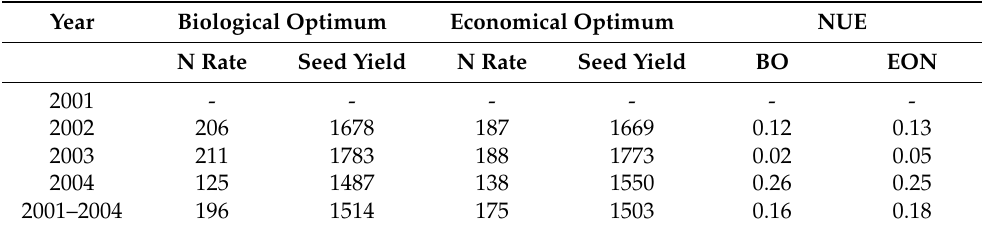
Table 4. Biological (BO) and economical optimum N (EON) application rate (kg N ha − 1 ) and appur- tenant estimated seed yield (kg ha − 1 ) for the four years and as an average of the four years, and nitrogen use efficiency (NUE) calculated for BO and EO within years and as an average of years. The nitrogen response curve was linear for 2001, and consequently, it was not possible to calculate BO nor